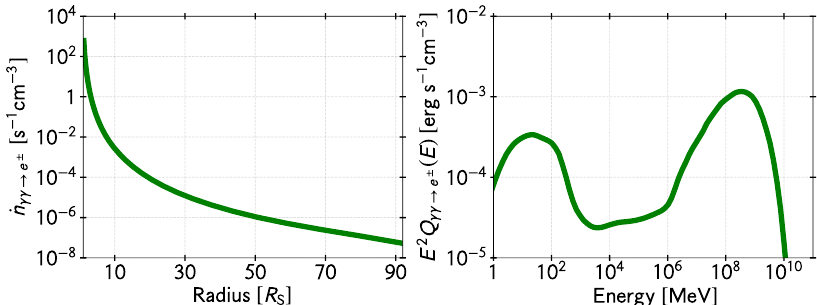
Figure 4. Electron-positron pair production in the accretion flow for the fiducial model discussed in the text. Left panel: Number of pairs created per unit time and volume by photon annihilation in the hot accretion flow as a function of the radius in units of the Schwarzschild radius (this is the distance to the black hole, along the equatorial plane of the disk). Right panel: Spectral energy distribution of these electron/positron pairs in the innermost